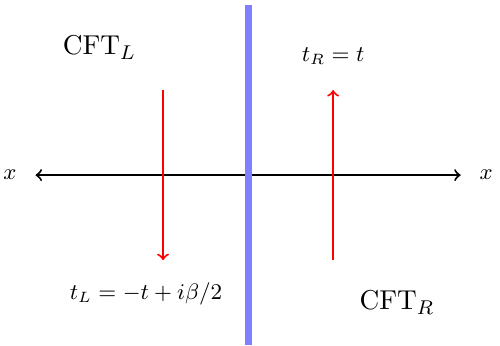
Figure 3 . The BCFT set up with two half-Minkowski spaces x ≥ 0 . There is also an imaginary shift which is naturally gives the